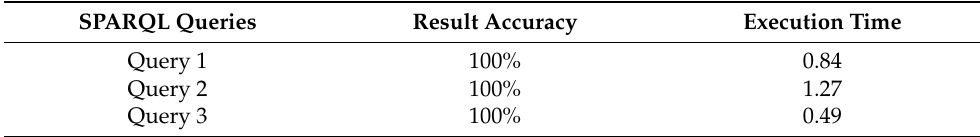
Table 2. Result accuracy and execution time for SPARQL